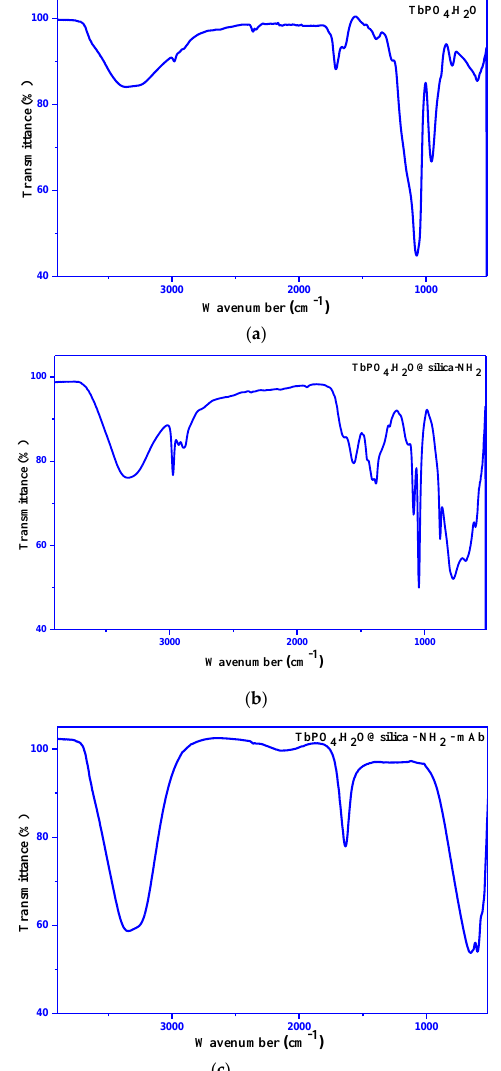
Figure 4. The FTIR spectra of TbPO 4 ·H 2 O ( a ), TbPO 4 ·H 2 O@silica-NH 2 ( b ), and TbPO 4 ·H 2 O@silica-NH 2 -mAb ( c ) obtained using a NICOLET impact 410 Fourier transform infrared spectrometer.